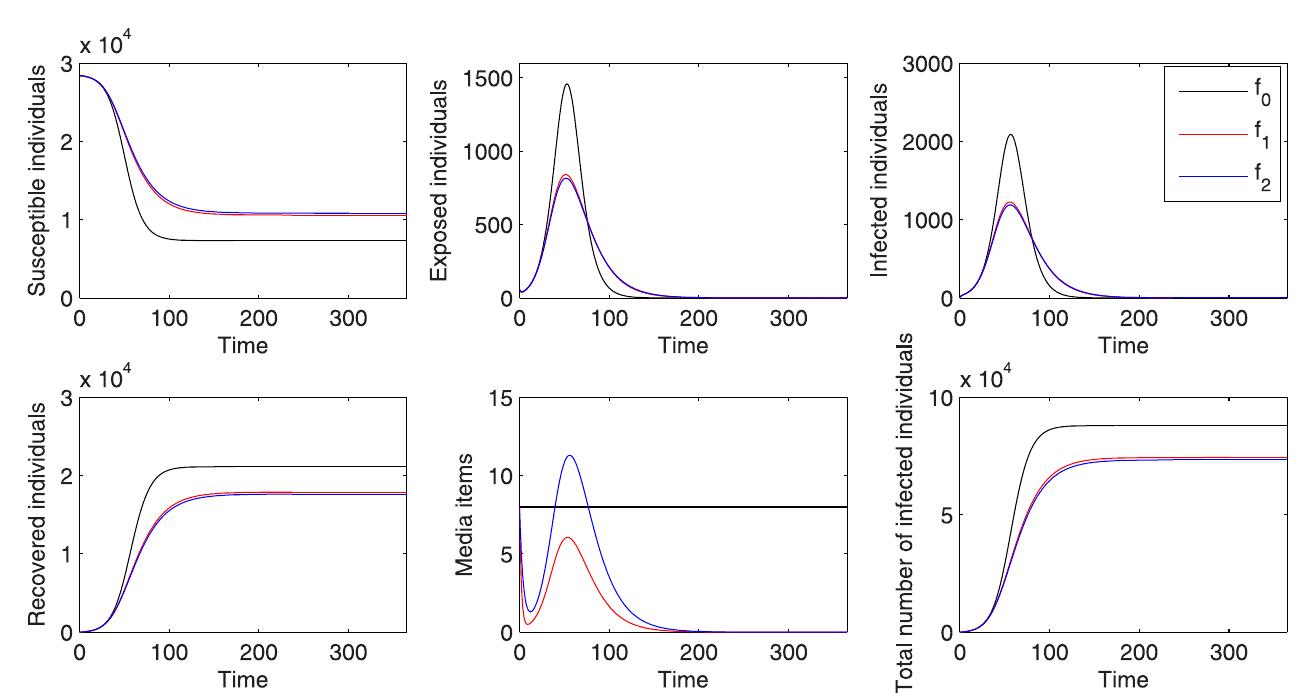
Fig 3. Comparison of solutions for system (1) with and without media effect. Black, red, blue curves represent the result of without media effect ( f 0 = 1), with media function f 1 = e − α 1 I − α 2 M , and with media function f 2